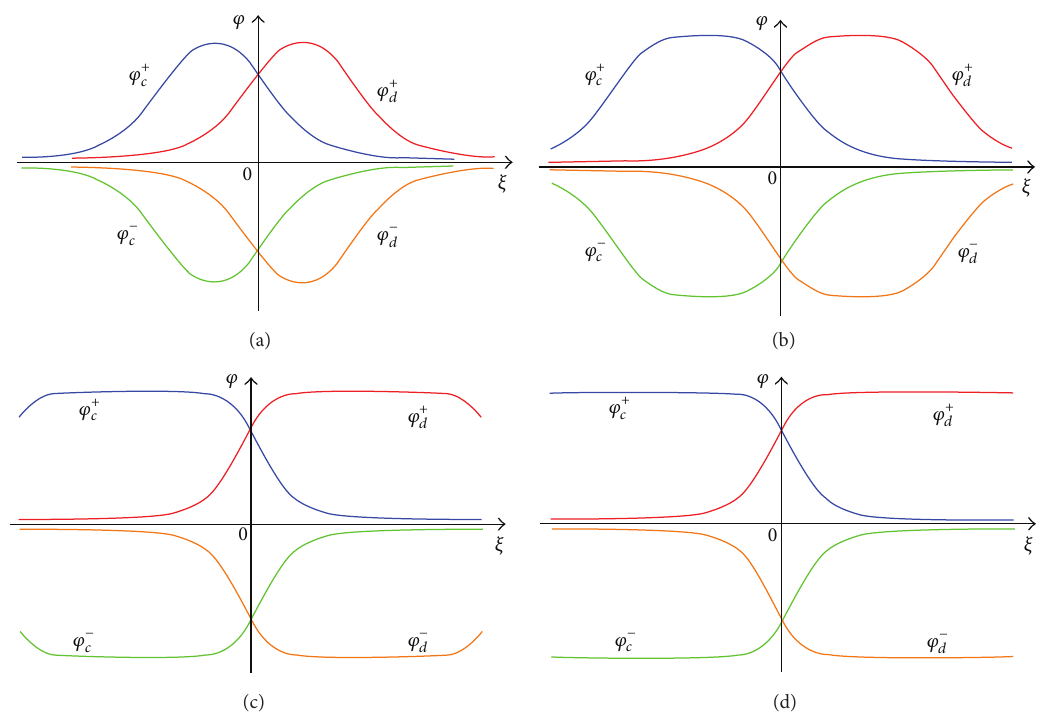
Figure 6: (The four low-kink waves are bifurcated from four symmetric solitary waves.) The varying process for the figures of 𝜑 ± 𝑐 and 𝜑 ± 𝑑 when (𝑞,𝑝) ∈ 𝐴 3 , 𝜆 > 0, 𝜆 ̸= √𝜆 0 /12 and 𝑝 → 3𝑞 2 /16𝑟 − 0 , where 𝑟 = 1 , 𝑞 = −4, 𝜆 = 4, and 𝑙 2 : 𝑝 = 3𝑞 2 /16𝑟 = 3 and (a) 𝑝 = 3 − 10 −1 , (b) 𝑝 = 3 − 10